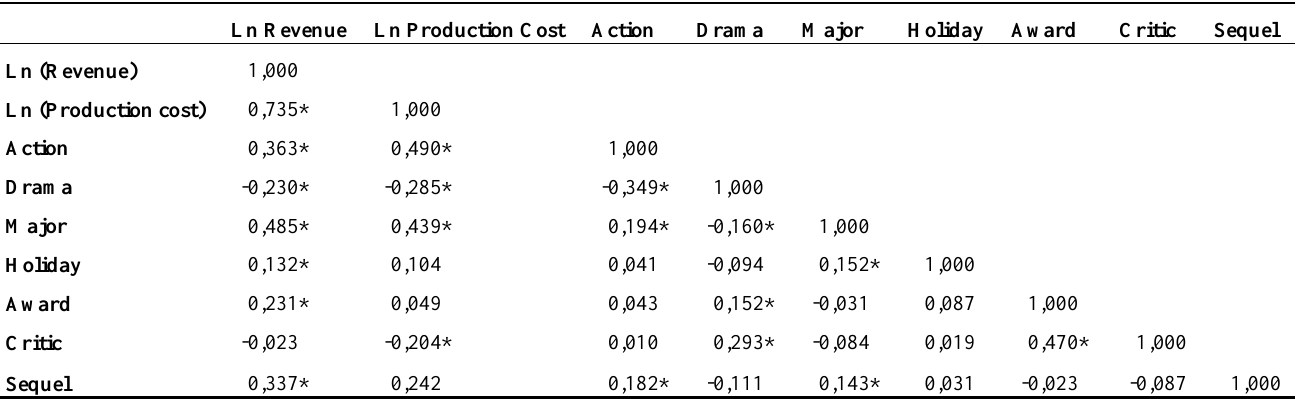
Table 2: Correlation matrix of independent and dependent